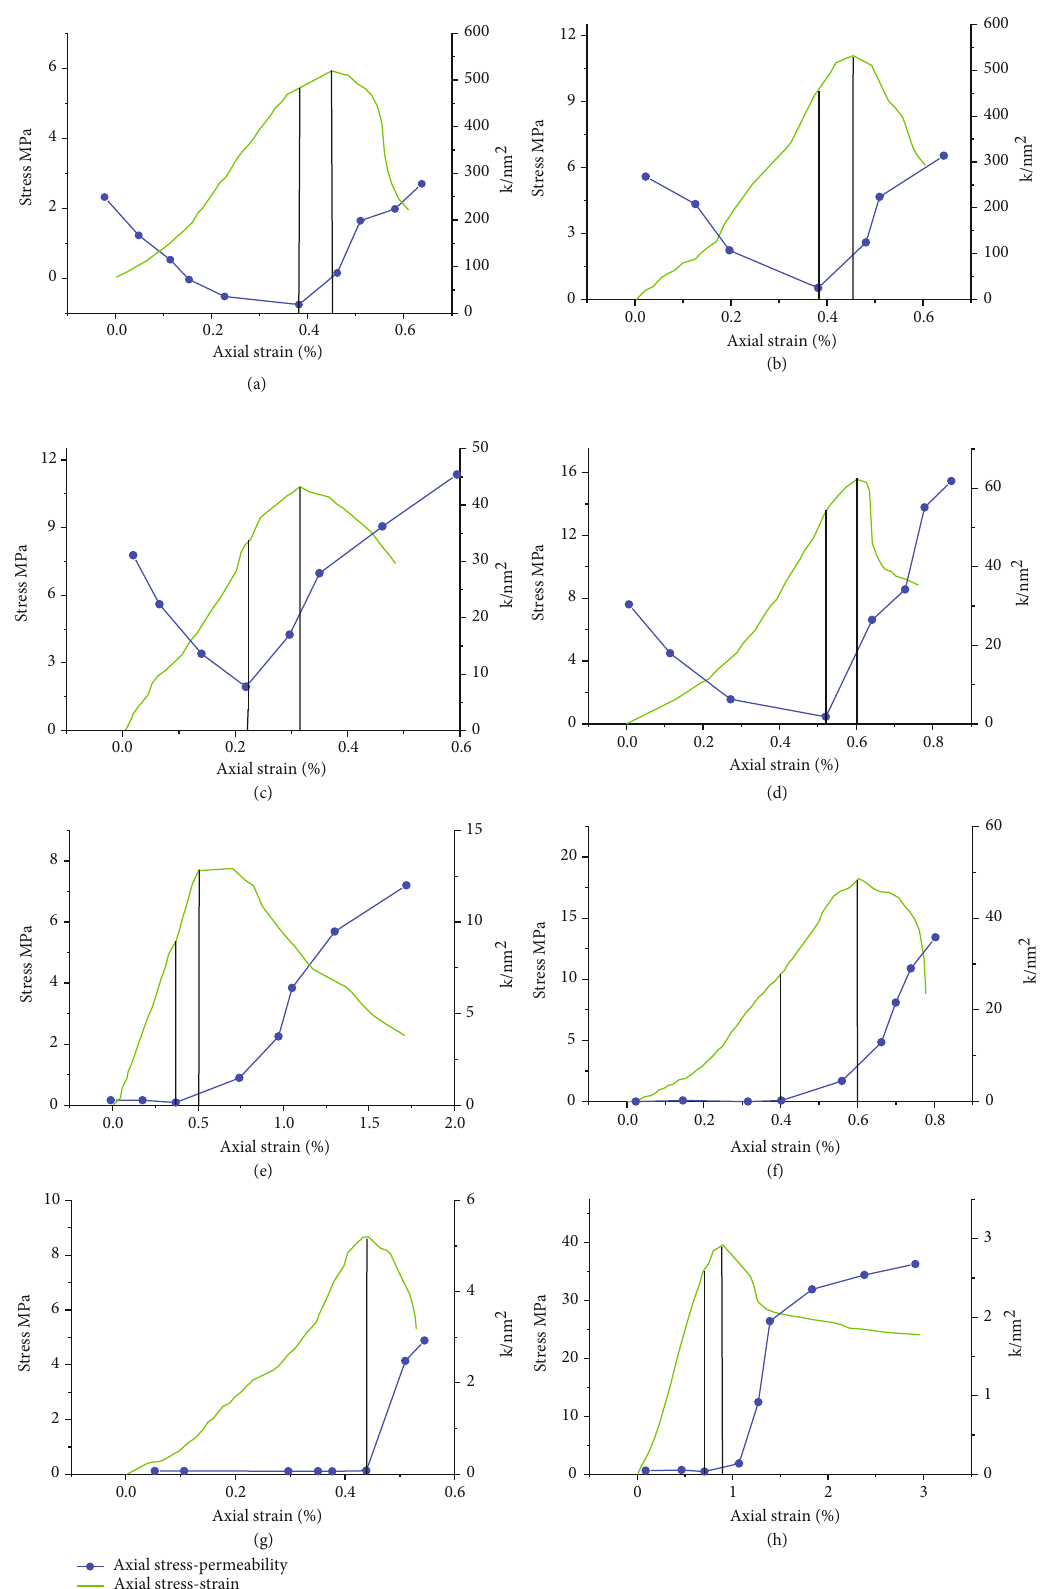
Figure 17: Stress-axial strain, permeability-axial strain diagram of the